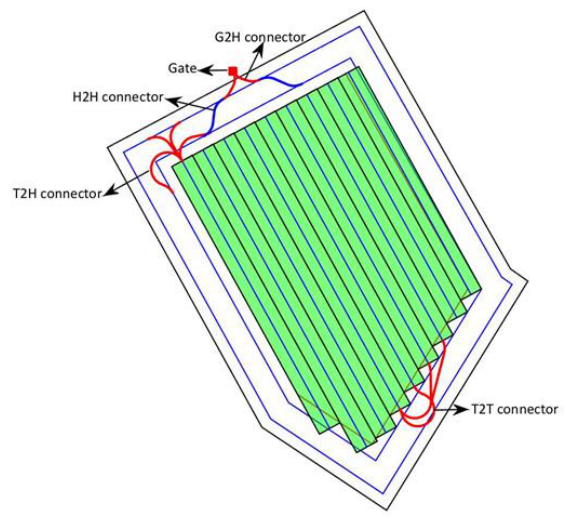
Figure 3. An illustrative example of four types of connectors.